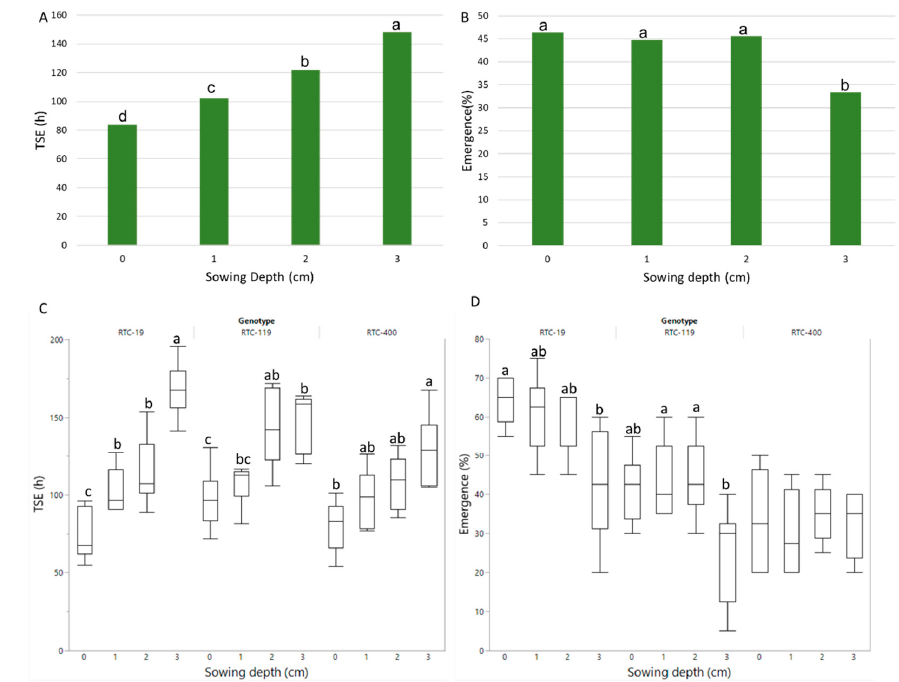
Figure 4. Pot experiment. Effects of sowing depth on ( A ) average time from sowing to emergence (TSE) and ( B ) emergence rate. TSE ( C ) and emergence rate ( D ) for each genotype and sowing depth. Different letters indicate significant differences ( p < 0.05) between sowing depths (on average and within each genotype).